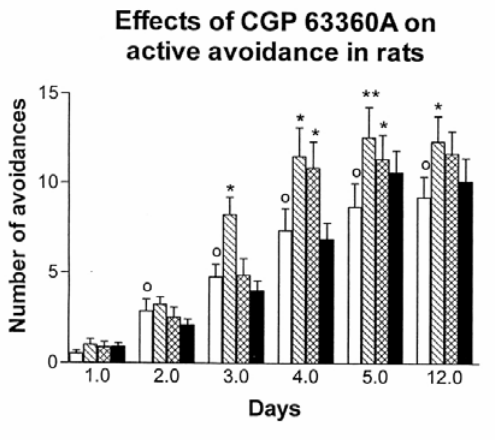
Fig. 1 Effects of the GABAB receptor antagonist CGP63360A on learning and memory processes in active avoidance